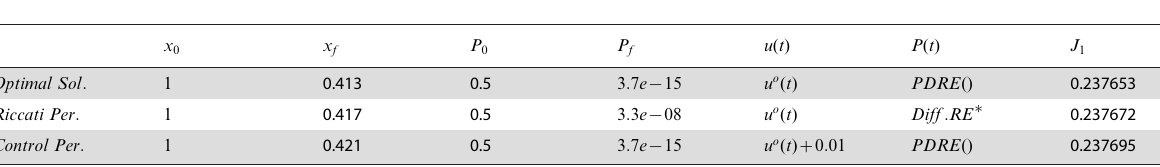
Table 1. The Values of Parameters in Simulation Case